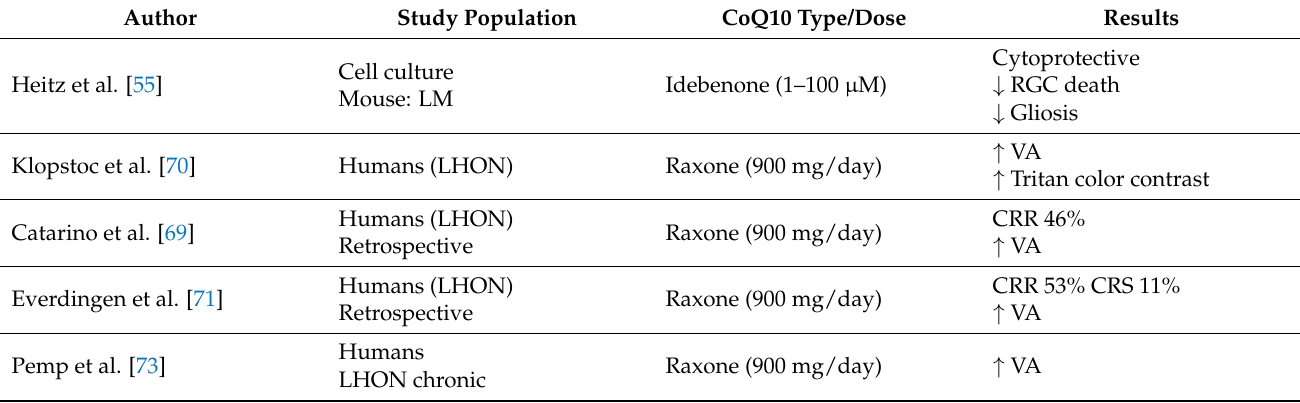
Table 5. Summary of articles that relate CoQ10 to